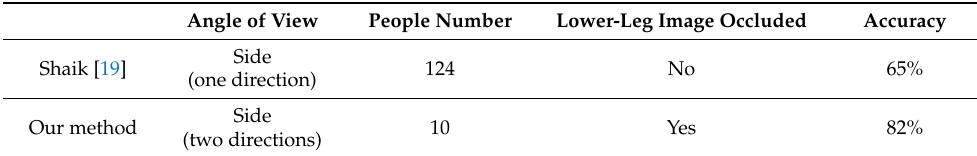
Table 1. Comparison of Shaik [19] to our method.